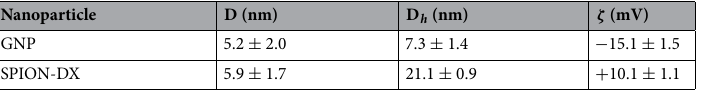
Table 1. Average physical (D) and hydrodynamic (D h ) diameters and zeta potential ( ζ ) of the NPs. TEM data were obtained from direct counting of individual particles. Hydrodynamic diameters and zeta potential were obtained from DLS measurements of NP dispersions in ultrapure water at physiological pH